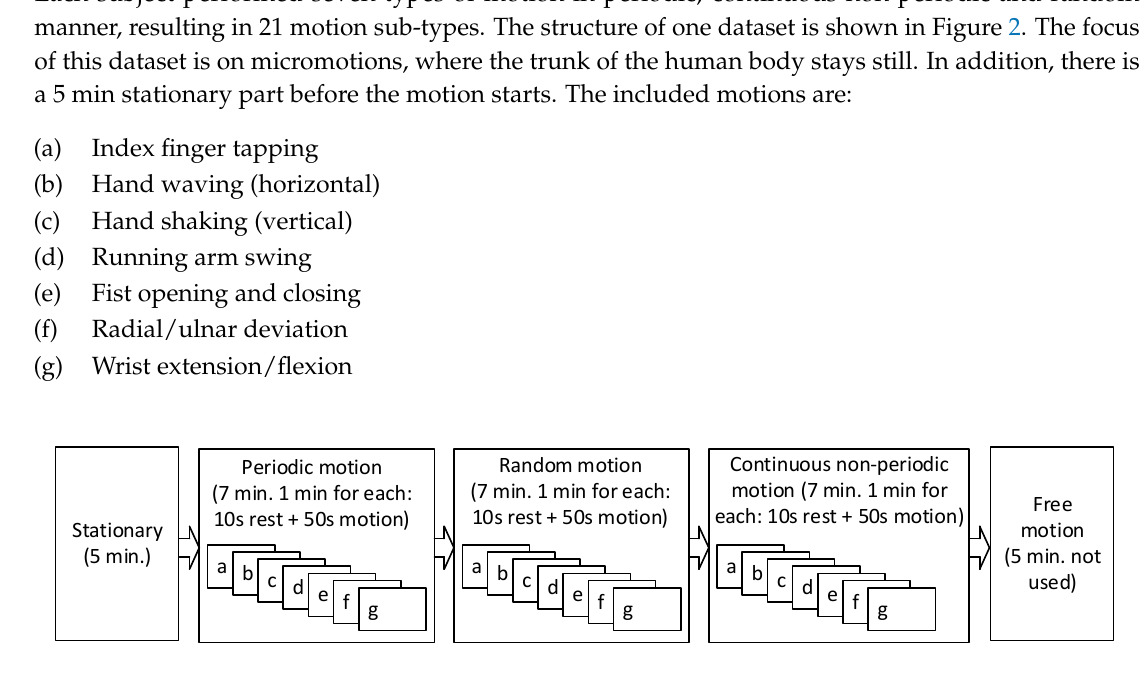
Figure 2. The structure of one dataset including stationary, periodic, random and continues non-periodic motion segment.